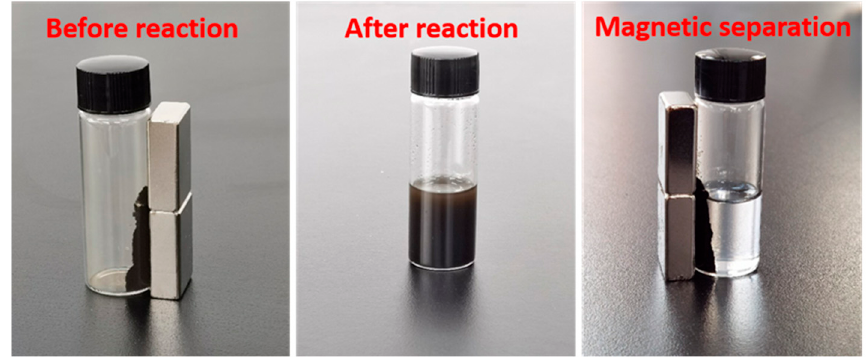
Figure 8. Images of magnetic characteristics and magnetic separation for reduced CuMgFe-4LDO catalyst.